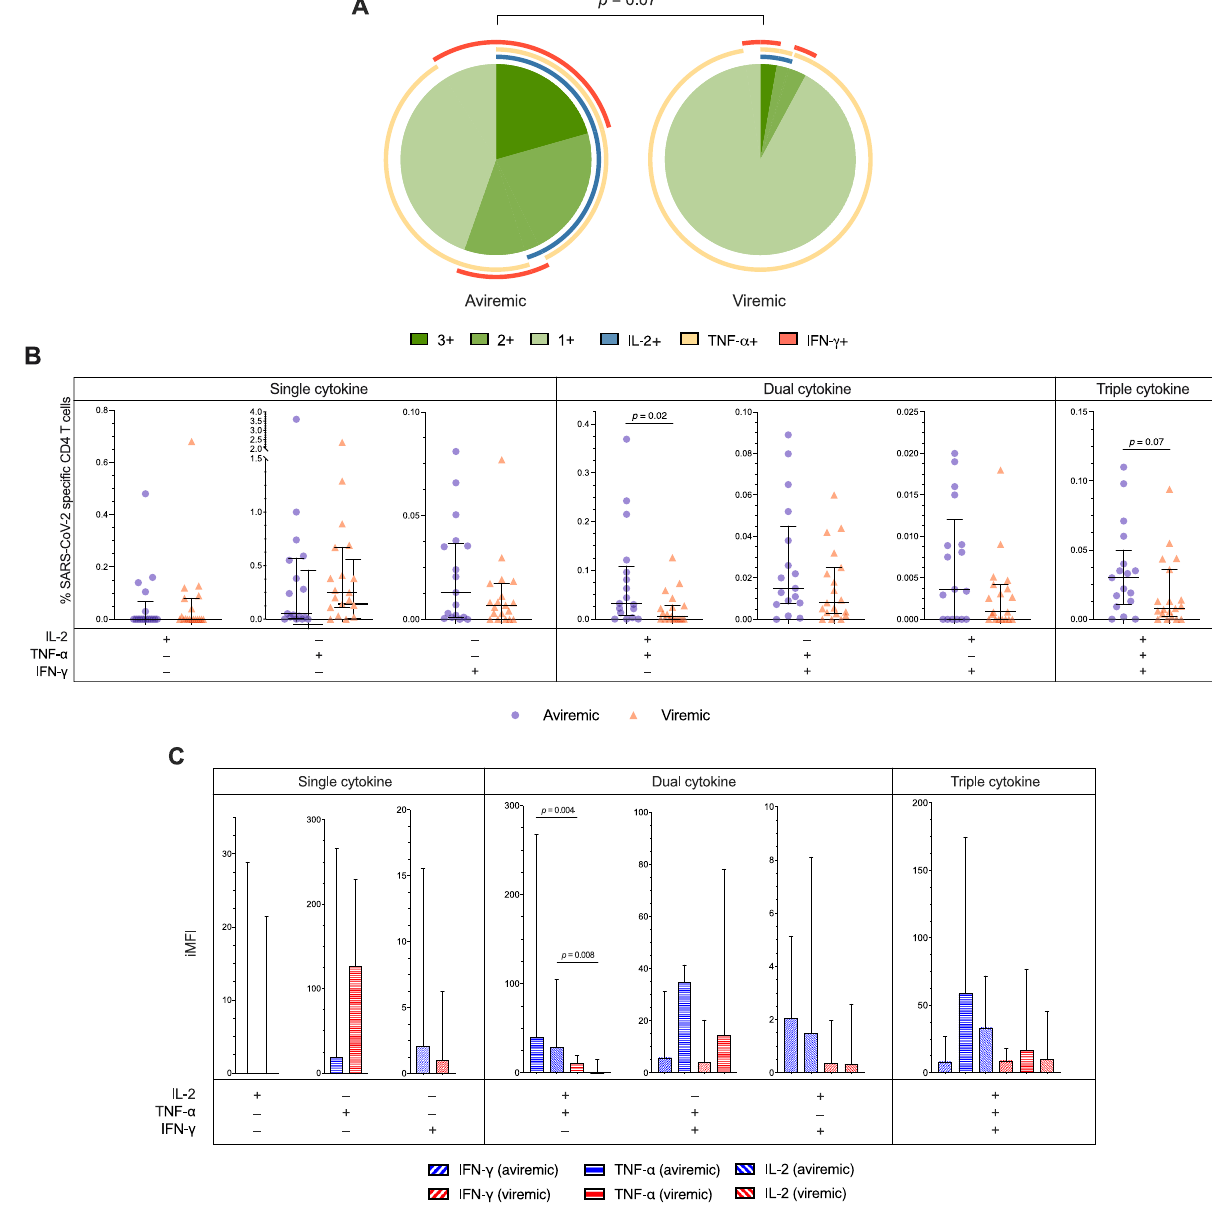
Figure 3. SARS-CoV-2 specific CD4 Th1 cells functionality in COVID-19 patients according to SARS- CoV-2 viremia. ( A ) Pie charts showing the median distribution of polyfunctionality profiles in SARS-CoV-2– specific cytokine-producing Th1 cells of aviremic and viremic individuals. The pie slices represent median percentages of tri- (3 +), bi- (2 +), and mono- (1 +) functional T-cells. The arches around the circumference indicate the cytokine (IFN-g, TNF-a, or IL-2) produced by the portion of T-cells that lie under the arc; parts of the pie surrounded by multiple arches represent polyfunctional cells. Statistics: permutation test performed by SPICE 6.0. ( B ) Th1 polyfunctionality: frequencies of CD4 T cells producing one Th1 cytokine (Single cytokine), two Th1 cytokines (Dual cytokine), or three Th1 cytokines (Triple cytokine) upon PBMCs challenge for 5 h with 1 μg/ml of a pool of 15-mer peptides of SARS-CoV-2 S-, N- and M-proteins in aviremic and viremic COVID- 19 patients (n = 19 and n = 17). ( C ) Magnitude of Th1 cytokines produced: the integrated median intensity patients (n = 19 and n = 17). Statistics: Mann–Whitney U test performed by SPICE